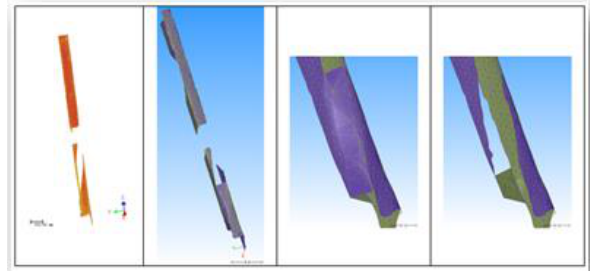
Figure 5a: Polygon meshes from point clouds with errors and removal of wrong triangles sections;